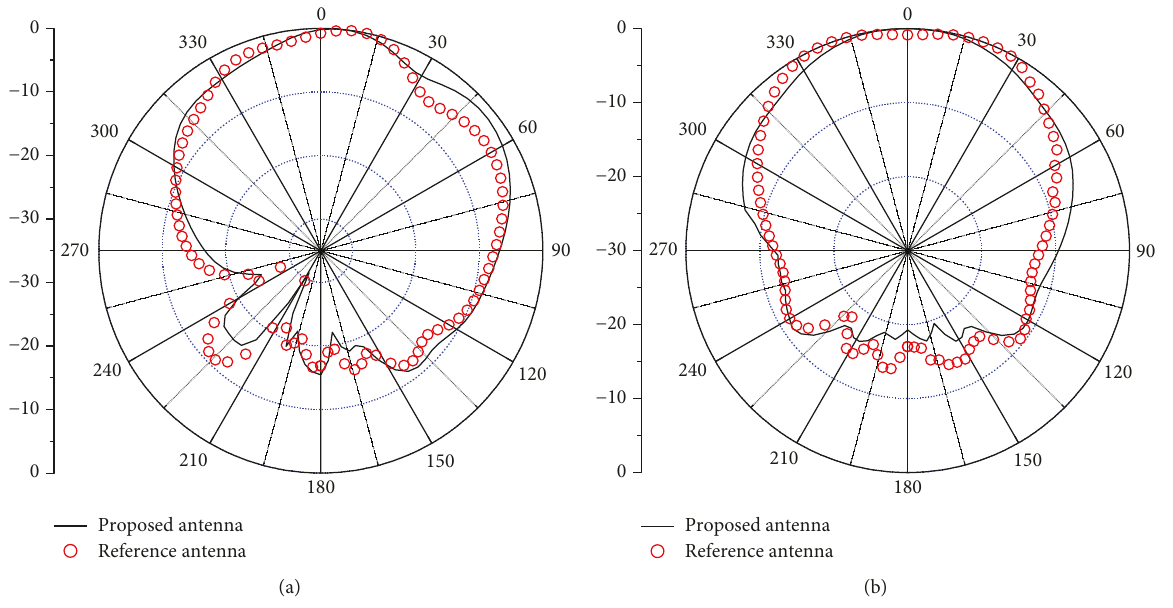
Figure 11: Normalized radiation patterns of the proposed and reference antenna at 14 GHz: (a) xz -plane; (b) yz -plane.